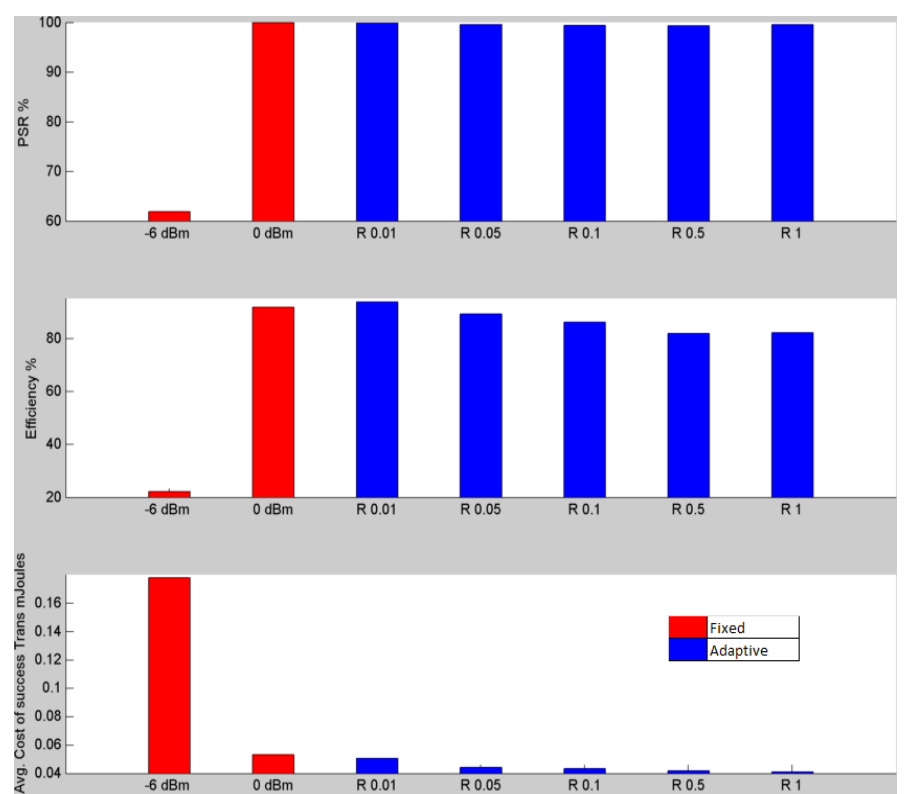
Figure 7. Comparison of the efficiency and average cost of successful transmission based on the PSR when the distance between the sensor and the hub is 24 m and collected during non-busy hours. The minimum energy consumption of fixed power is achieved at 0 dBm The adaptive protocol consumes 29% less energy than the fixed power transmission at 0 dBm when R = 1 The efficiencies of the adaptive protocol (at R = 1) and fixed power transmission (0 dBm) are